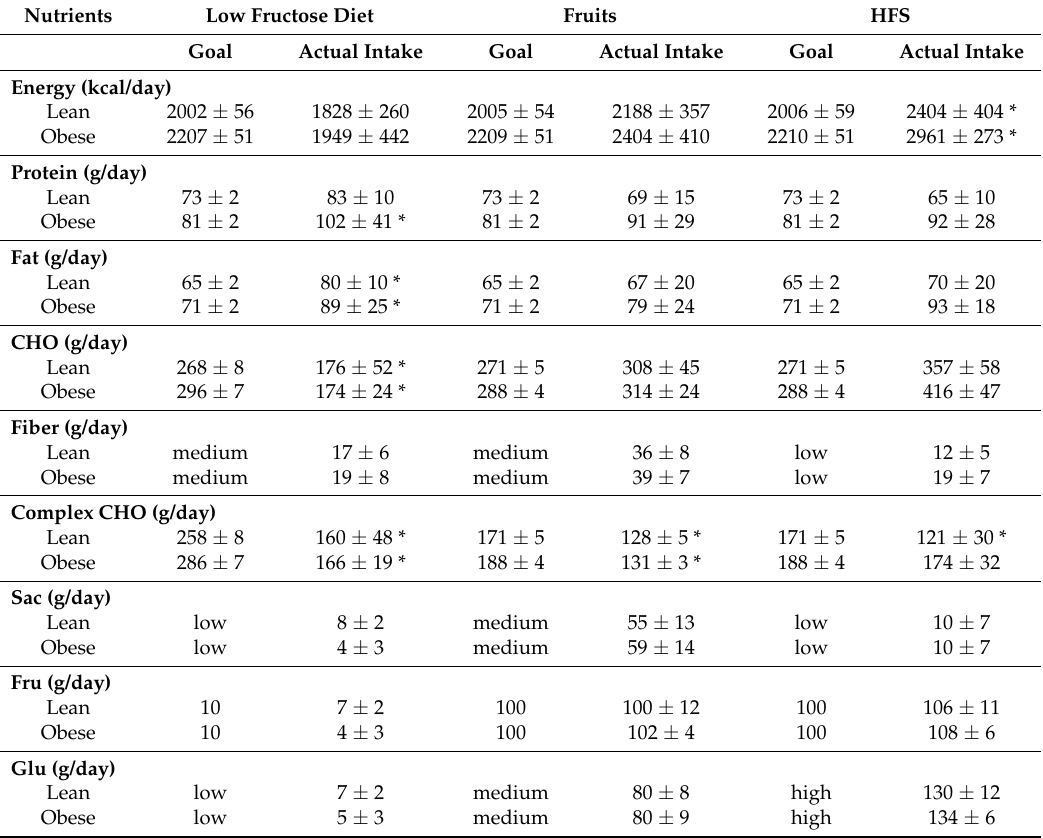
Table 2. Composition of study